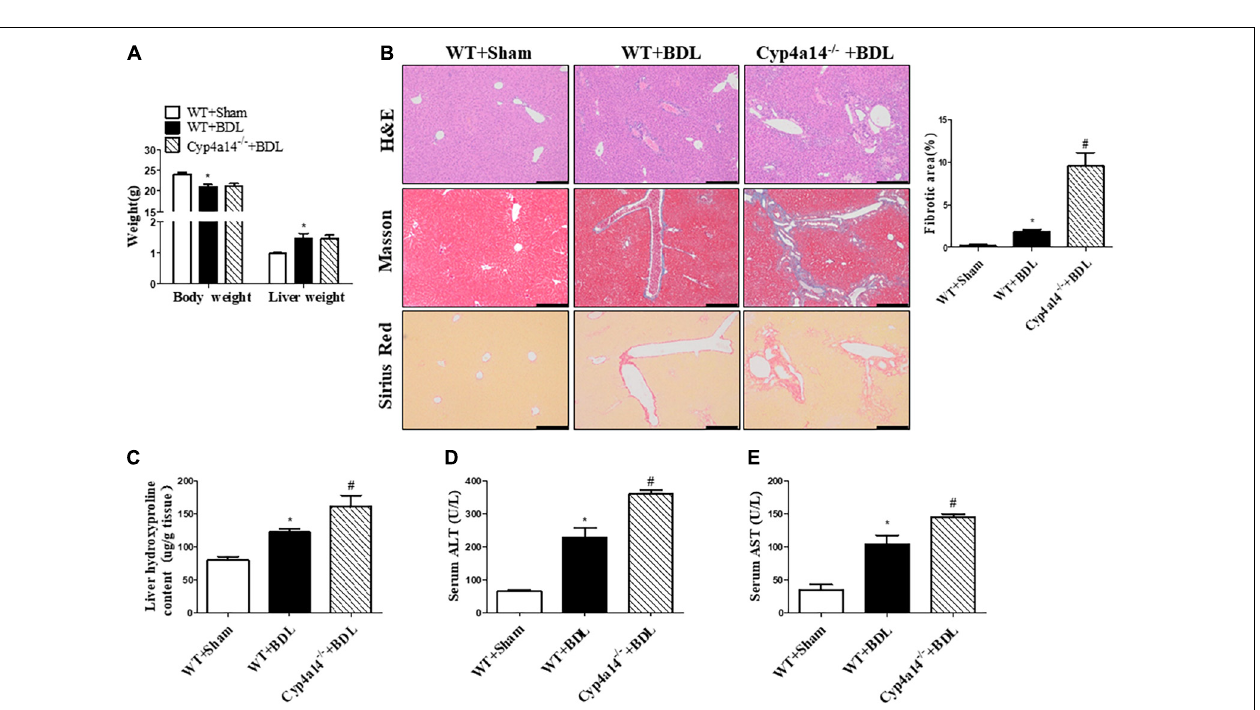
FIGURE 1 | The expression of Cyp4a14 was decreased in the bile duct ligation (BDL)-induced fibrotic liver. (A) Real-time PCR assay demonstrating that Cyp4a14 mRNA expression was significantly decreased in BDL mice. (B) Western blot analysis showing a significant decrease in hepatic Cyp4a14 protein expression in BDL mice. n = 5, * p < 0.05, Sham and